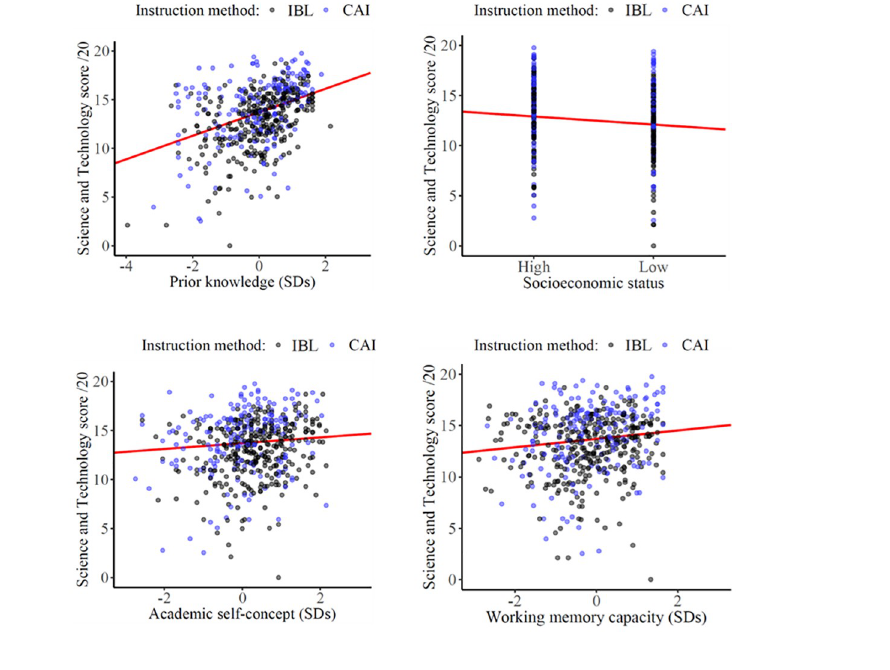
Fig 4. Estimated regression coefficient effects of prior knowledge, socioeconomic status, working memory and academic self-concept on Science and Technology scores (Model 4).